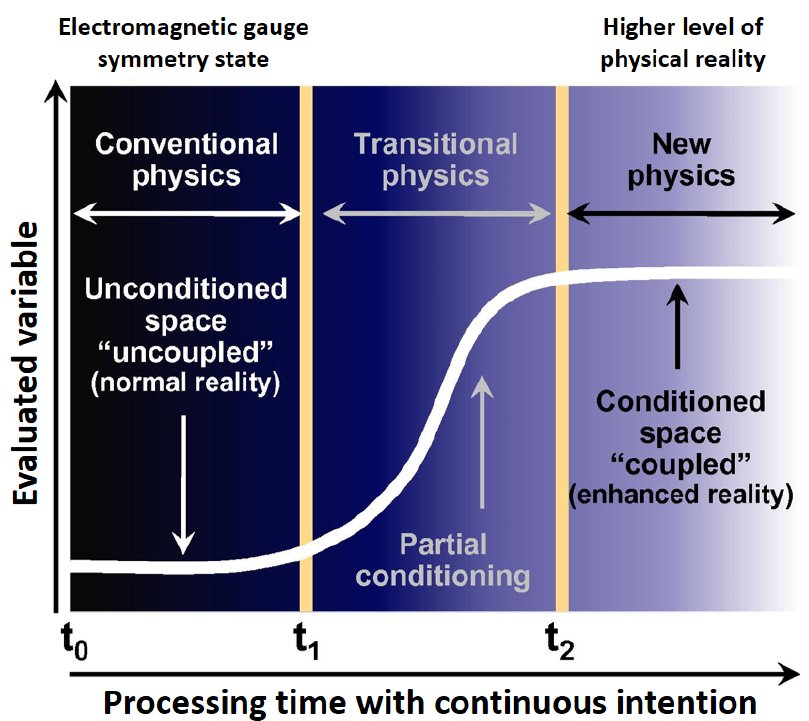
Figure 4. The time-evolution pattern of a n intention target experiment. Reprinted with permission from [78]. Copyright 2011 Elsevier (Amsterdam, The Netherlands) and Copyright Clearance Center (Danvers, MA, USA). Time-dependent conditioning of a space in which a variable is measured, for example, water pH, under a continuous intention. As time goes on (time zero – t 0 ; time one – t 1 ; time two – t 2 ), the electromagnetic gauge symmetry state of the space changes from uncoupled to coupled and consequently to a higher level of physical reality (higher electromagnetic gauge symmetry state).